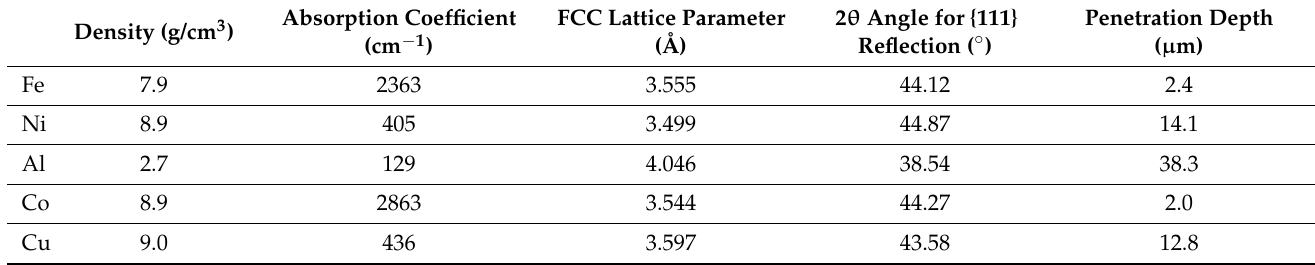
Figure 8. Diffraction-angle dependent penetration depth of Cu K α X-rays in Fe. The absorption threshold was set at 95 %. The schematic in the inset illustrates the Bragg–Brentano geometry. The width of the beam indicates the number of X-ray photons transmitted. Table 4. Calculated penetration depths at 5% penetration (I/I 0 , as in Equation (4)) for Fe, Ni, Al, Co, and Cu, for in-house XRD diffractometers using a Cu K α source in a Bragg–Brentano (reflection) geometry. These values also serve as ballpark guidance for Fe, Ni, Al, Co, and Cu